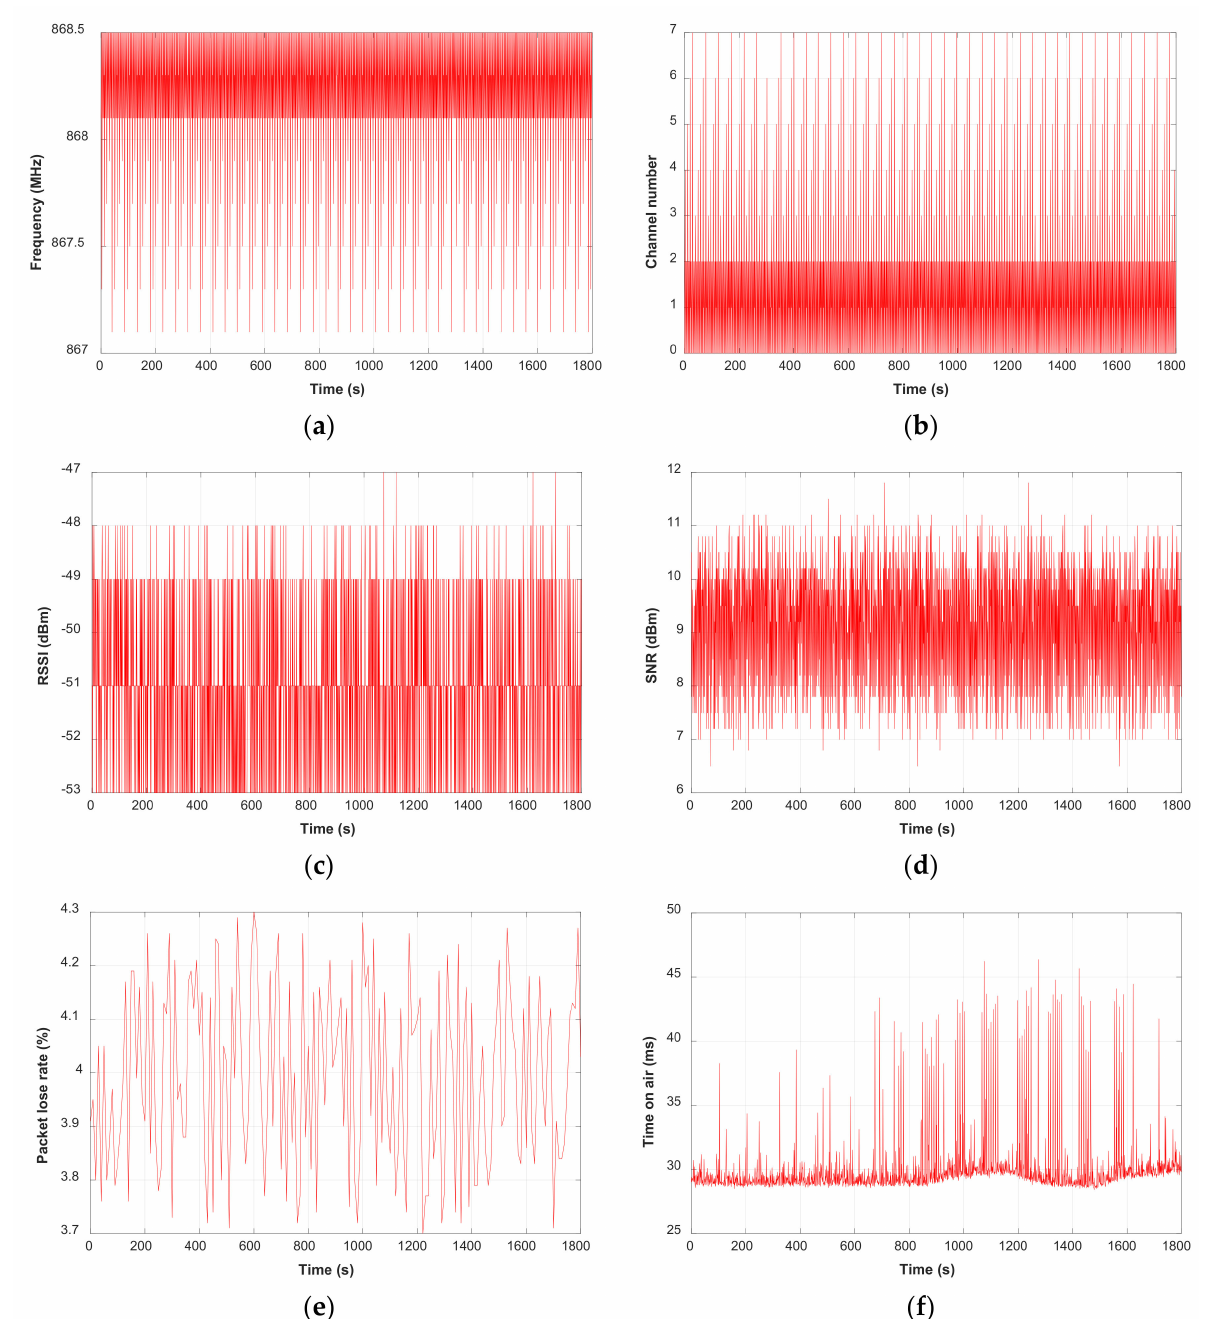
Figure 17. Measurements on the LoRa network: ( a ) frequency; ( b ) channel number; ( c ) RSSI; ( d ) SNR; ( e ) PLR; and ( f ) time on